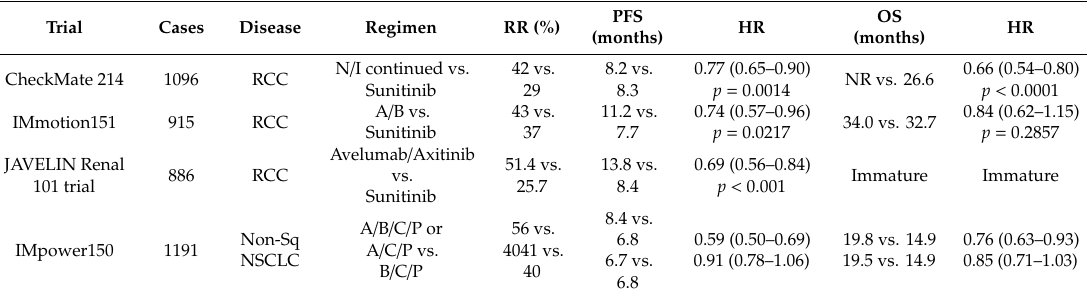
Table 2. Phase III trials examining combination therapies of immune checkpoint inhibitors (ICIs) and antiangiogenic